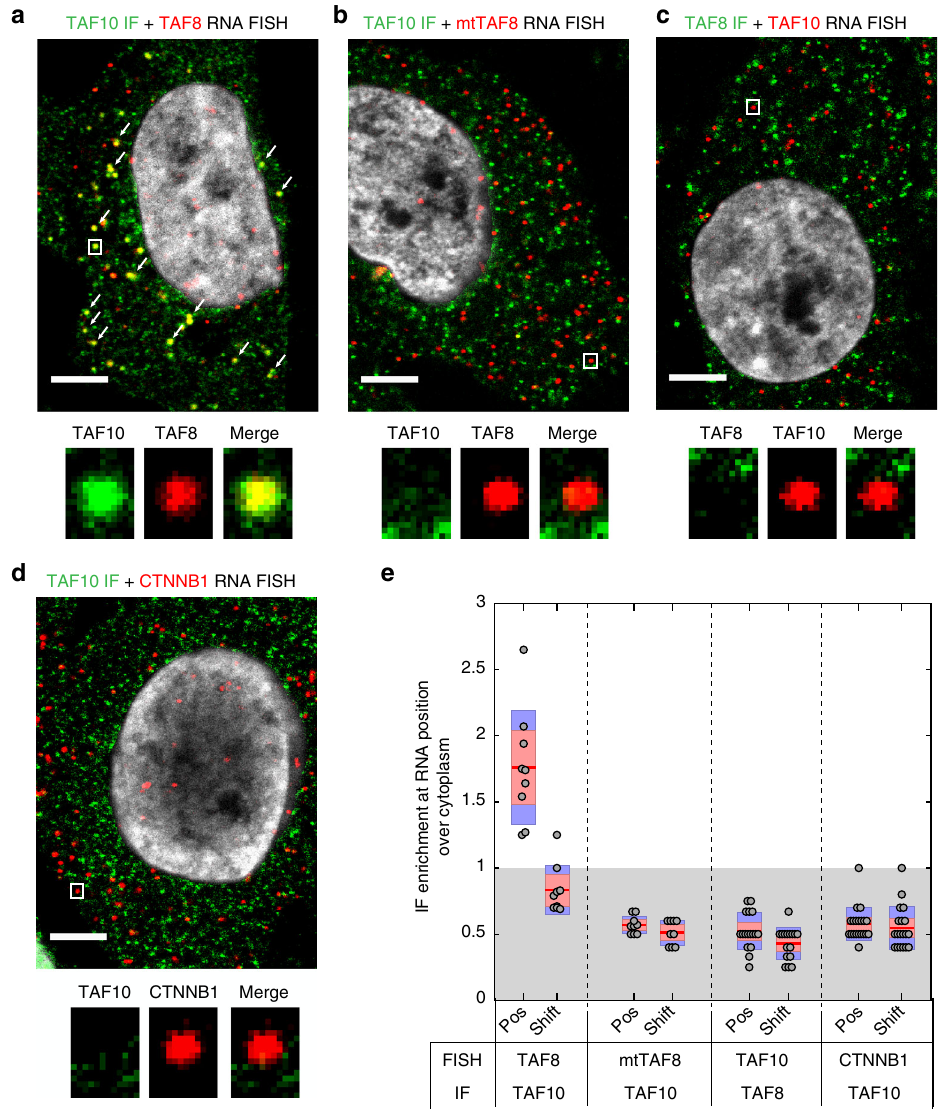
Fig. 5 Co-localization of TAF10 protein and TAF8 mRNA in cytoplasm. a , b IF-smiFISH images in HeLa cells expressing either wild-type FLAG-TAF8 or mutant (mt) FLAG-TAF8 (TAF8 S57F L65F). Labels: red, Cy3-labelled TAF8 probes; green, Alexa-488 labelled secondary antibody for TAF10 protein; co- localizing spots are indicated with white arrows. c , d Representative IF-smiFISH images of endogenous TAF10 mRNA and TAF8 protein ( c ) and CTNNB1 mRNA and TAF10 protein ( d ) in HeLa cells. Labels: red, Cy3-tagged TAF10 FISH probes ( c ) and CTNNB1 probes ( d ); green, Alexa-488 labelled secondary antibody for TAF8 ( c ) and TAF10 ( d ) protein. A typical cell recorded in each case and after counterstaining the nucleus with DAPI (grey) is shown. The nuclear signal in the green channel (TAF10 or TAF8 IF) was removed by masking the nucleus and using the “ clear ” option in ImageJ. Zoom-in regions shown under every image are indicated with a white rectangle. Scale bar (5 μ m). e Boxplot showing enrichment ratios of IF signal at each RNA position over mean cytoplasmic intensity under all the conditions tested. Each grey dot represents one cell. Red horizontal lines are mean values, 95% con fi dence interval is shown in pink, and standard deviation in